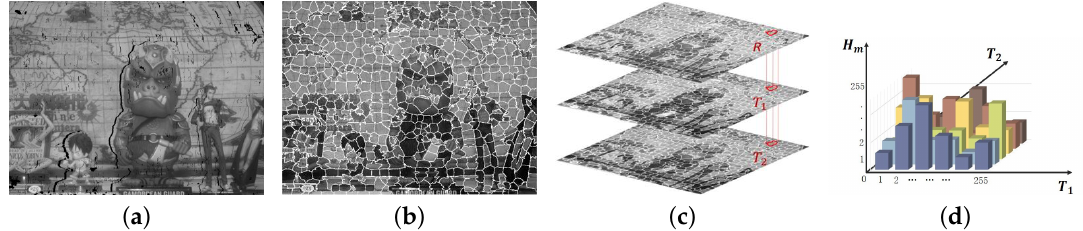
Figure 10. Segmentation process of the DCA image and CMM: ( a ) initially aligned reference channel R using the estimated disparity; ( b ) a segmented target channel using superpixels; ( c ) segmentation results of all three channels; and ( d ) the segment-wise CMM.